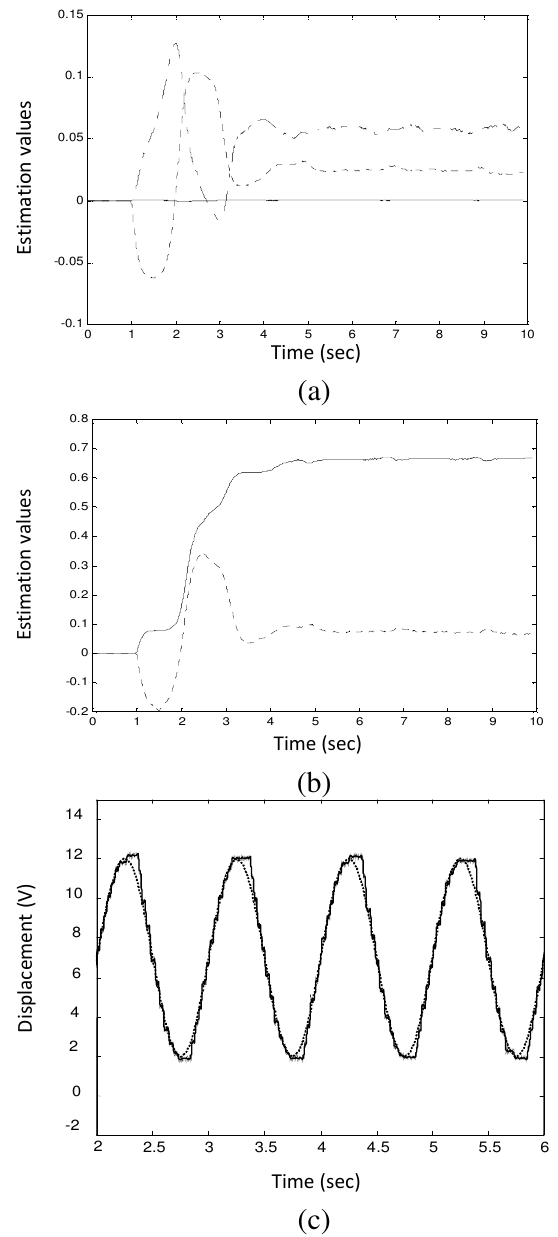
Figure 4. Parameter identification for valve V line; (b) â : solid line, â : dot line; (c) the tracking signal (solid line) and the reference input f 0 (dot line) during